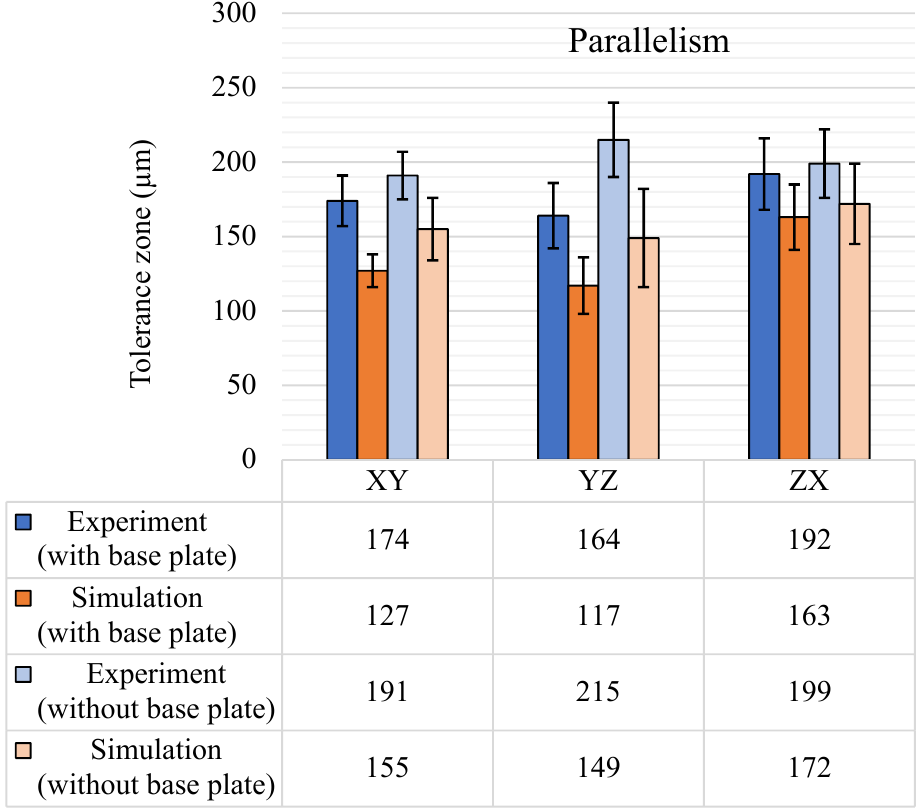
Figure 14. Parallelism (µm) tolerance results, with and without the base plate.